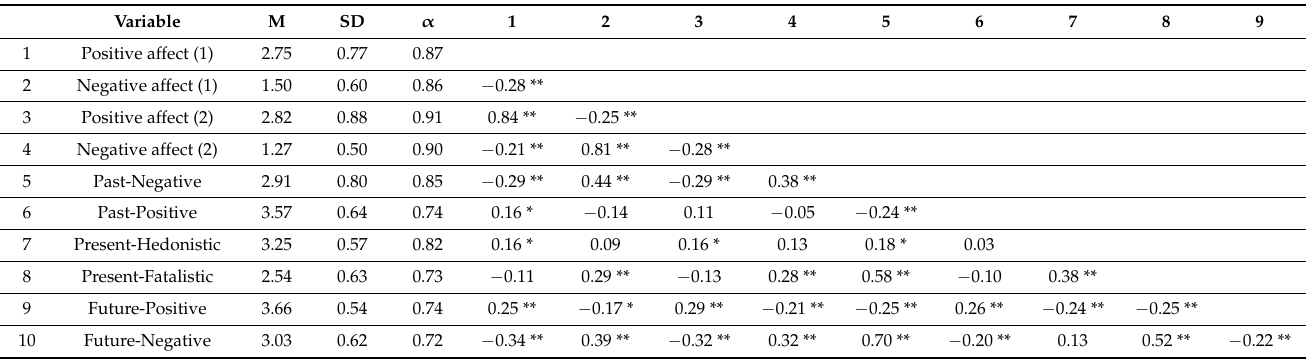
Table 1. Means, standard deviations, Cronbach’s alphas, and intercorrelations between variables included in the study (N =